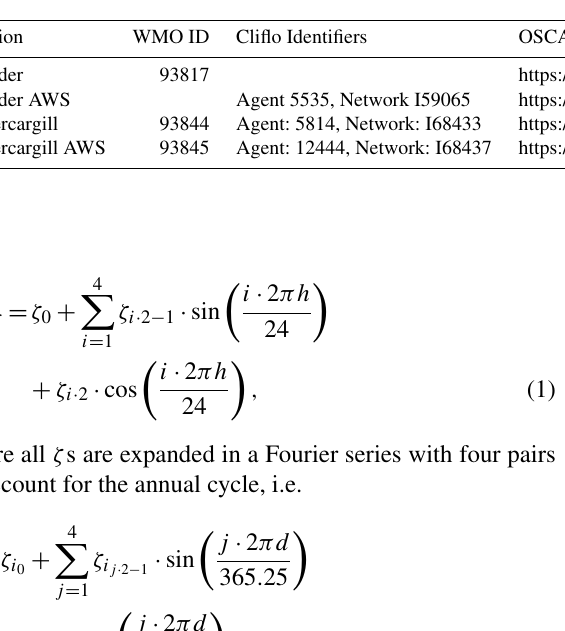
Table 2. Station details for Lauder and Invercargill, including the World Meteorological Organization (WMO) station identifier (ID). The Agent and Network number are required to identify the station in New Zealand’s National Climate Database. The Observing Systems Capability Analysis and Review (OSCAR) tool is WMO’s official repository of metadata on surface-based